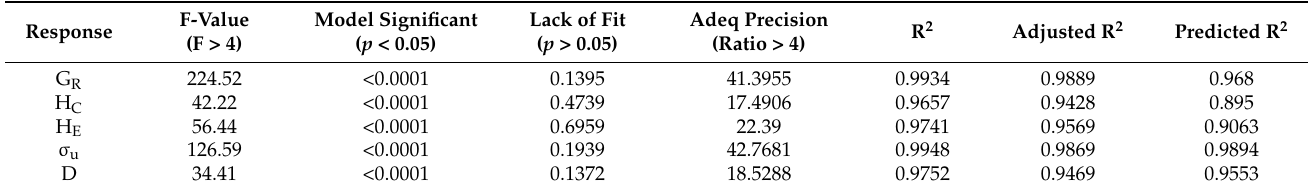
Table 4. Statistical tests of ECAP responses.